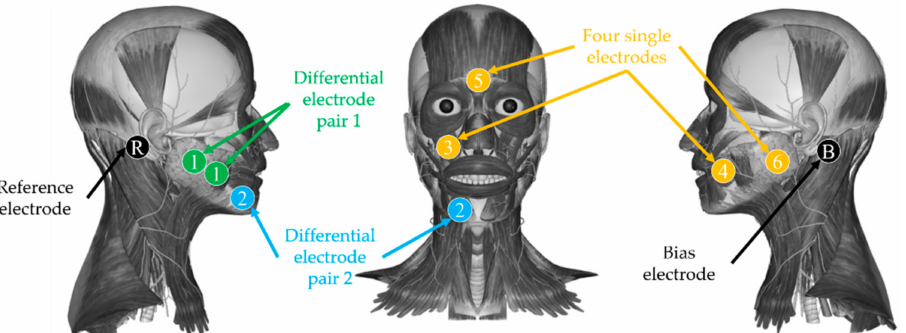
Figure 2. Electrode distribution. The circles indicate the position of electrodes, and the numbers denote the index of 6 channels. Electrodes for channels 1 and 2 are differential electrode pairs. Circles with the letter ‘B’ and ‘R’ are the positions of the bias electrode and reference electrode. Electrodes for channels 1 and 6 were arranged on masseters. Electrodes for channel 2 were arranged on depressor anguli oris. Electrodes for channels 3, 4, and 5 were arranged on levator labii superioris, risorius, and procerus, respectively. In addition, the bias electrode and reference electrode were arranged on the left and right mastoid,